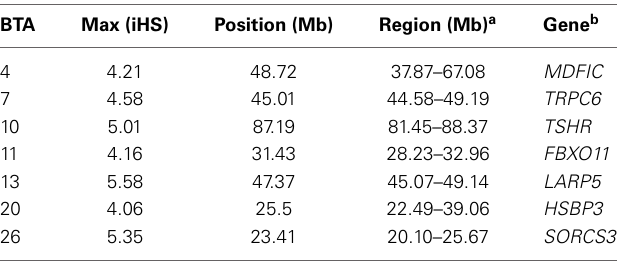
Table 2 | Signatures of selection in Kenyan